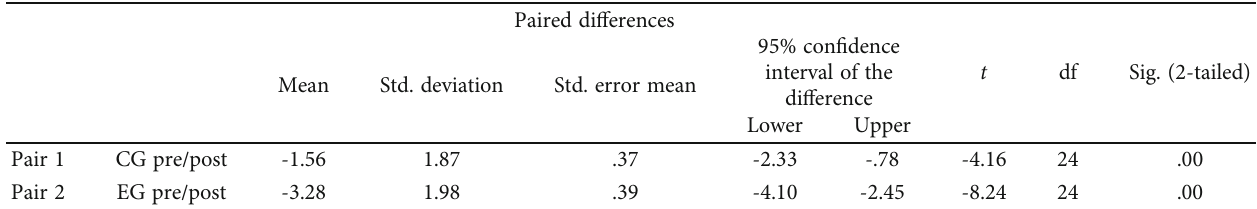
Table 5: Comparing the grammar pre- and posttests of each group (paired samples T